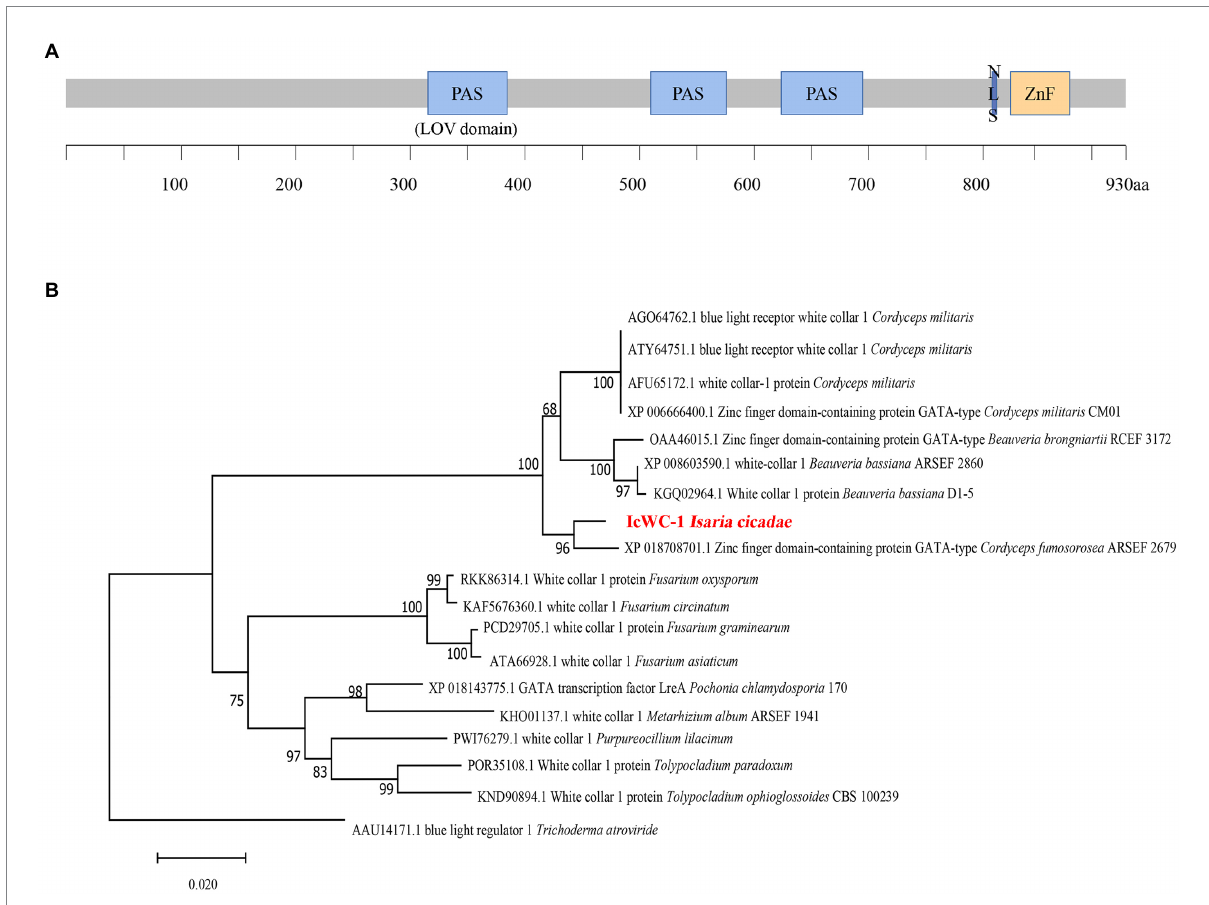
FIGURE 1 The domain organization of IcWC-1 protein and the Phylogenetic tree of IcWC-1. (A) The regions corresponding to LOV, PAS domains, the nuclear localization signal (NLS) and ZnF are shown. (B) Phylogenetic tree of WC-1 homologous proteins from fungi. The amino acid sequences of WC-1 homologous proteins from different species were downloaded from the NCBI database for phylogenetic analyses (protein sequences in Supplementary Material). The topology of this tree was generated using neighbour-joining (NJ) method of MEGA7 with 1,000 bootstraps replicates. These numbers represent the percentage of replication trees (1,000 replications) with related taxa clustered together in the boot